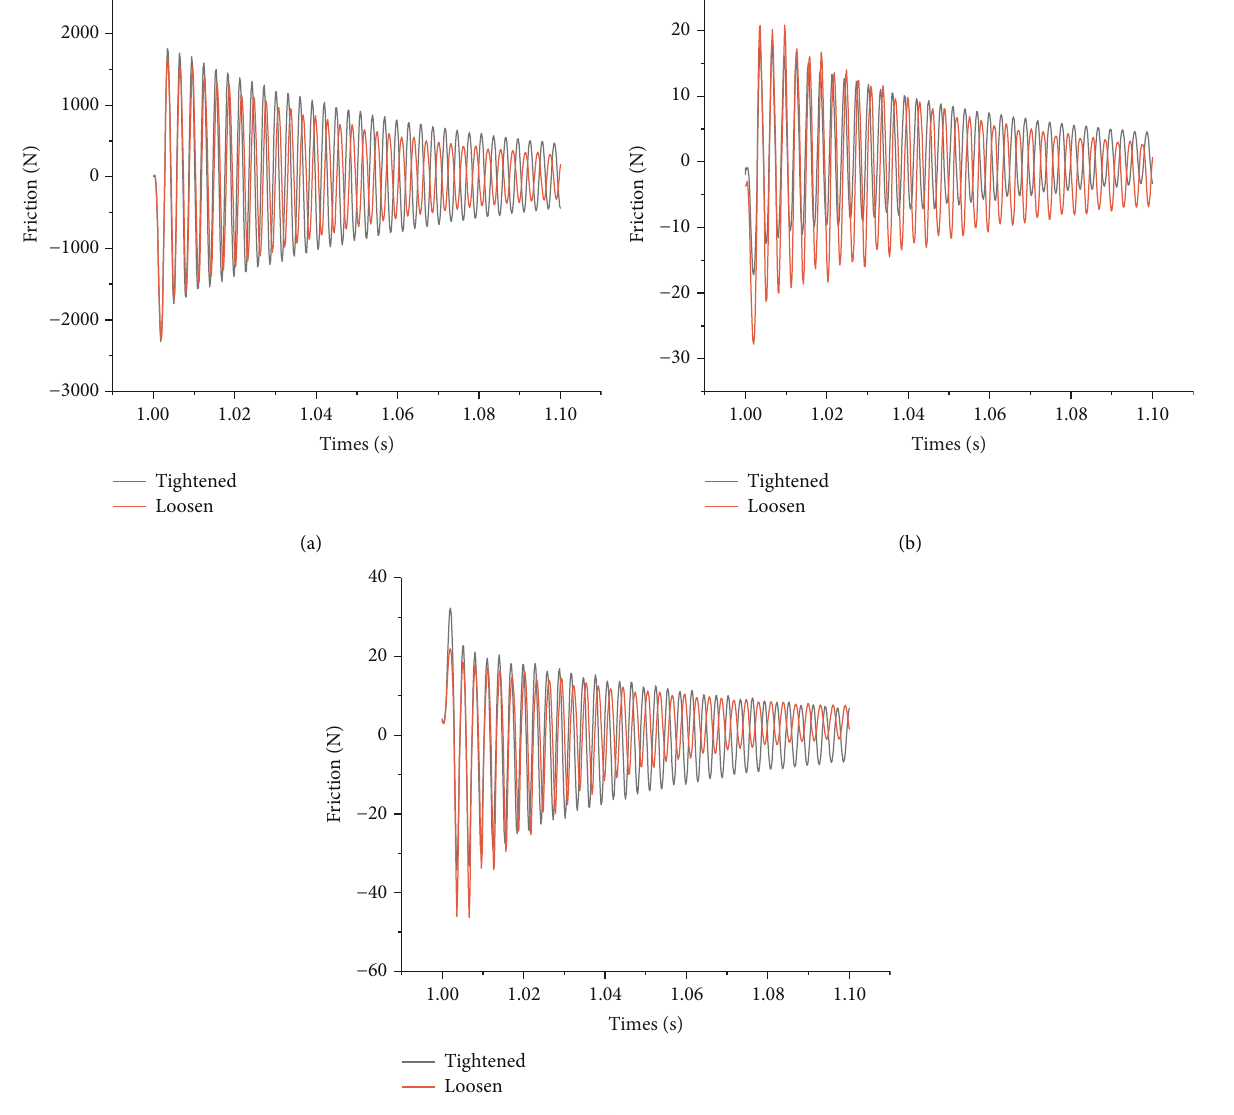
Figure 19: x -direction horizontal projection bolt local friction (under 1.5 kN impact load on the top). (a) Flange surface. (b) Nut surface. (c) Thread